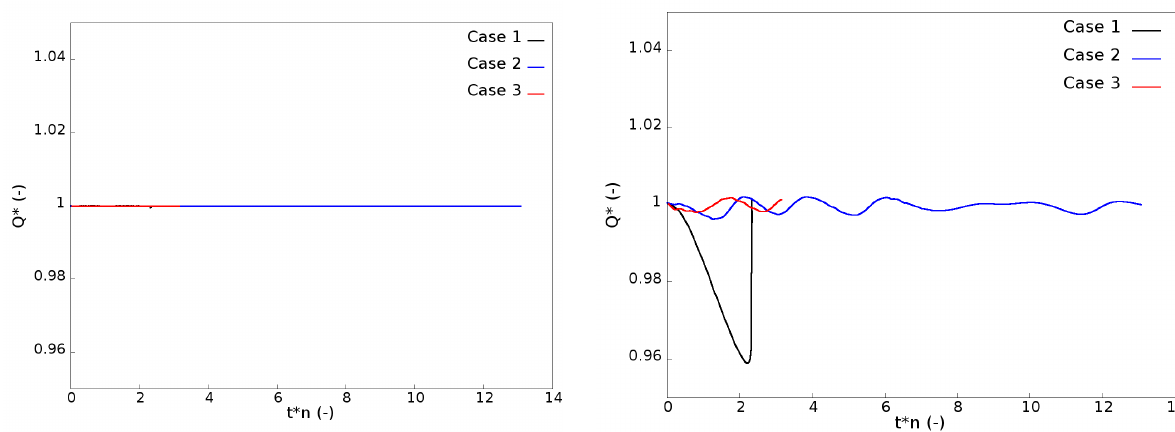
the mass flow oscillates. The oscillation is stronger for Case 1 with a strong decrease of the mass flow, which is a consequence of the vapour volume growth (see Figure 5).